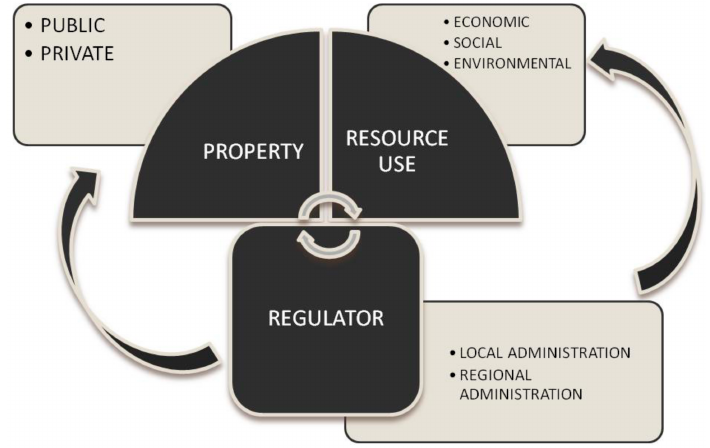
Figure 4. Distribution categories of stakeholders.